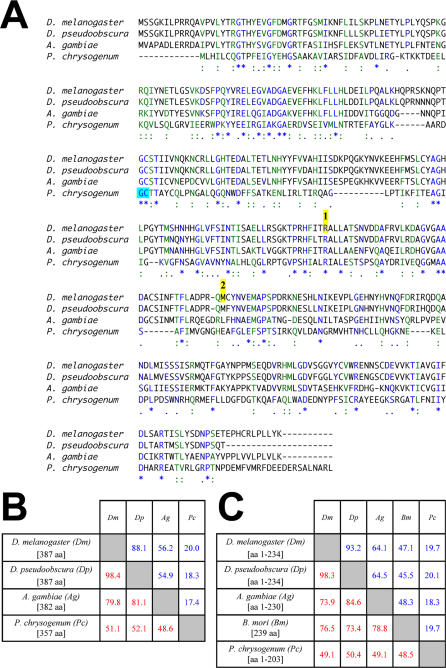

Drosophila CG12120 Is Conserved across Insects and Is Related to Fungal IAT(A) Alignment of D. melanogaster, D. pseudoobscura, and A. gambiae CG12120 orthologs and P. chrysogenum IAT protein. Residues in blue are identical (*) across all four species, and residues in green are functionally similar, showing strong (:) or weak (.) similarity. Residue highlighted “1” indicates conserved arginine residue at position 217 that is mutated to proline in tan1 and tan4 mutants. Residue highlighted “2” indicates methionine residue at position 256 that is mutated to isoleucine in tan5 mutant. Cyan rectangle indicates auto-processing site of P. chrysogenum at which pro-IAT is cleaved between glycine 102 and cysteine 103.(B) Percent sequence identity (blue in upper right) and sequence similarity (red in lower left) among Drosophila spp., A. gambiae, and P. chrysogenum proteins.(C) Percent sequence identity (blue in upper right) and sequence similarity (red in lower left) of N-terminal Drosophila spp., A. gambiae, and P. chrysogenum proteins with presumptive B. mori CG12120 ortholog (see text).